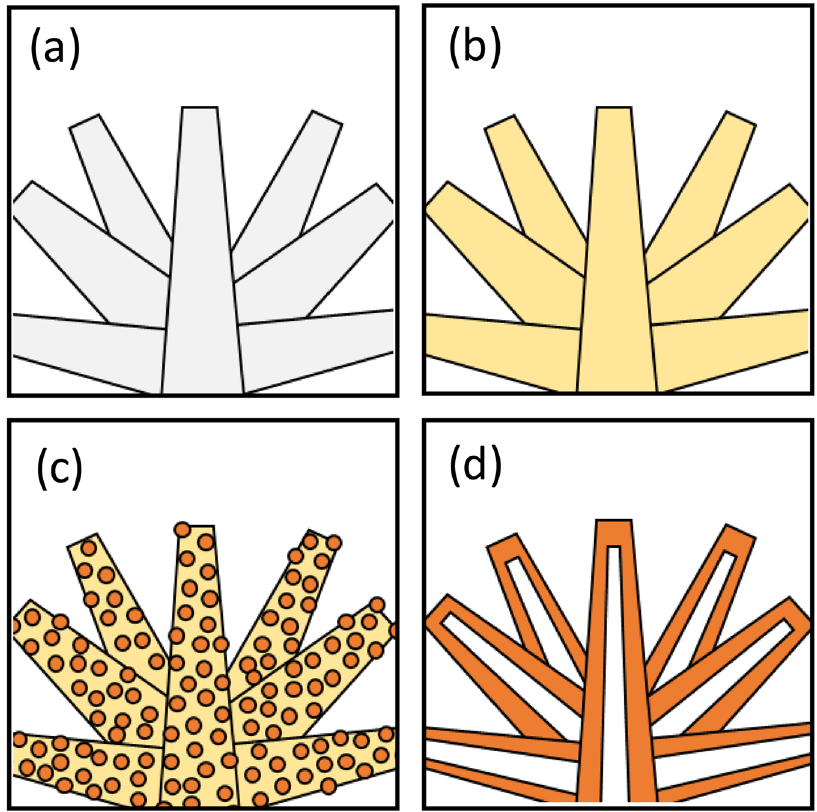
Figure 7. The microstructural evolution of the sample during the transformation to α -Al 2 O 3 ; ( a ) the agglomeration of the rod-like aluminium formate hydroxide particles (Fig. 1(b)), ( b ) the precursor powder was thermally decomposed to form the amorphous phase (Fig. 4(a)), ( c ) the highly condensed nucleation of nanocrystallites in the rod-like grains (Fig. 4(b)) and ( d ) α -Al 2 O 3 grains with hollow rod-like structure (Fig.